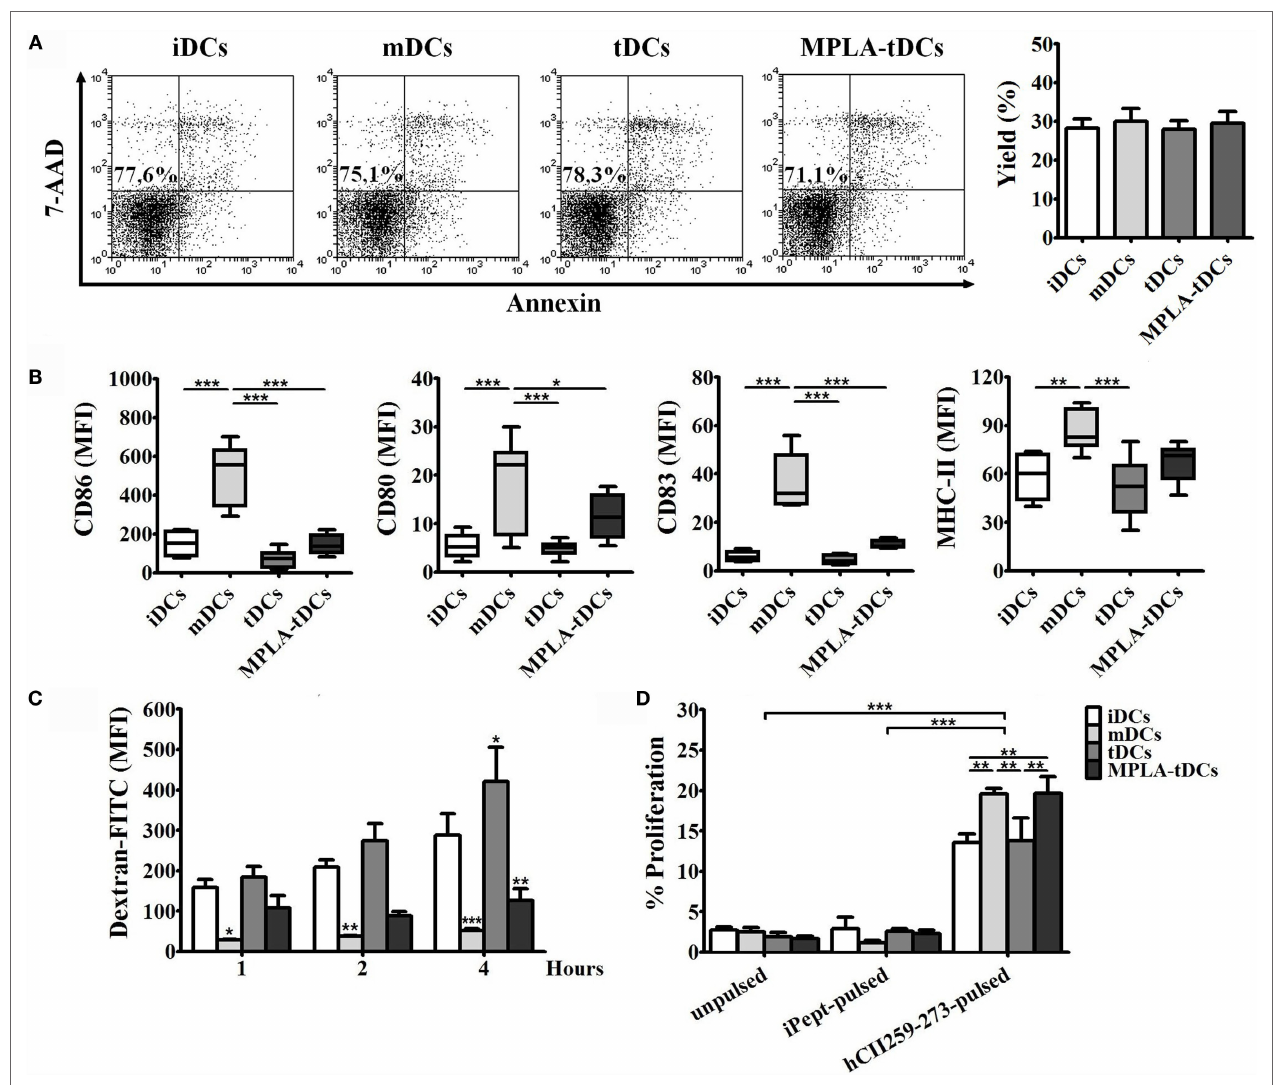
FigUre 1 | MPla-tDcs are characterized by low expression of maturation markers, diminished endocytosis ability, and the capability to present antigen efficiently . For the induction of a tolerogenic state, DCs were conditioned with dexamethasone (Dex) and were additionally activated with MPLA (MPLA-tDCs). Untreated DCs (iDCs), Dex-modulated DCs (tDCs), and MPLA-matured DCs (mDCs) were used as controls. ( a) Representative dot plots of cell viability measured after 5 days of culture and expressed as the percentage of annexin-V and 7-AAD-negative cells are shown, and DC yield is expressed as a percentage of DCs obtained on day 5 related to the initial number of monocytes cultured per condition (mean ± SEM) ( n = 10). (B) Surface expression levels of CD86, CD80, CD83, and HLA-DR were assessed by flow cytometry. Graphic analyses of MFI measurements are expressed as box-and-whiskers plot from minimum to maximum values ( n = 6). Statistical differences were calculated using one-way ANOVA for repeated measures followed by Tukey post-test (* P < 0.05; ** P < 0.01; *** P < 0.001). (c) Endocytosis capacity was assessed by incubating DCs with dextran-FITC during 1, 2, and 4 h. Results are expressed as the difference between MFI of cells incubated at 37 and 4°C with the antigen and are represented as the mean ± SEM of four independent experiments.